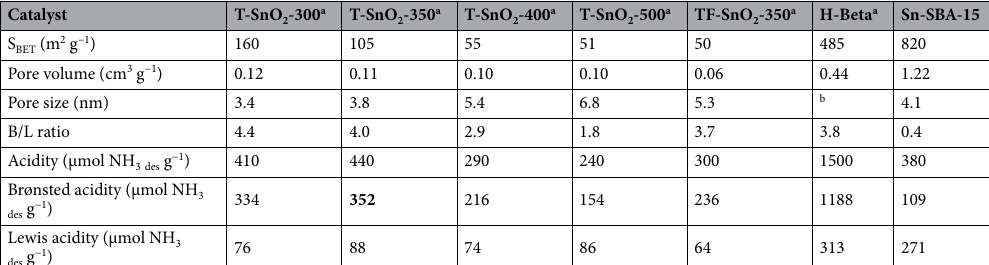
Table 1. Textural and chemical properties of tin oxide and other solid acid catalysts. a Reference 3 , b 0.66 × 0.67 nm and 0.56 × 0.56